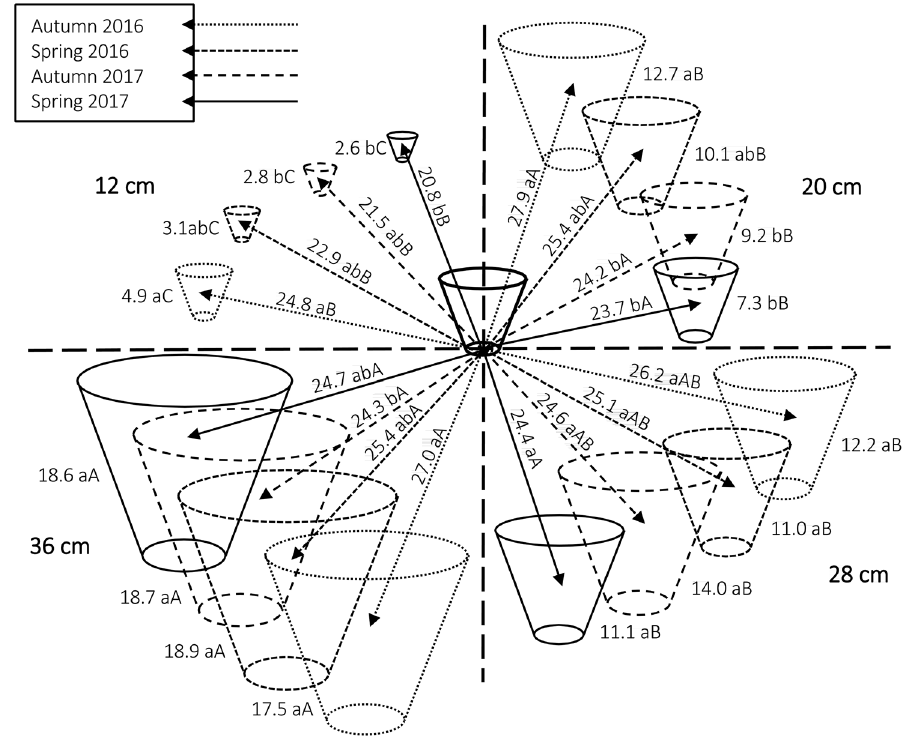
Figure 2. Changes in tussock volume (represented by cones; dm 3 ) across seasons (each quadrant corresponds to a treatment canopy height) and inter-tussocks distance (represented by arrows; cm) of Andropogon lateralis . Values followed by the same letter do not differ. Lowercase letters compare seasons within canopy heights and uppercase letters compare canopy heights within seasons. The central cone represents the average tussock volumes before the implementation of treatments in August 2015. This figure was created by the authors using the Microsoft® Word for Mac, 16.50 (https:// www. office. com/ launch/ word?